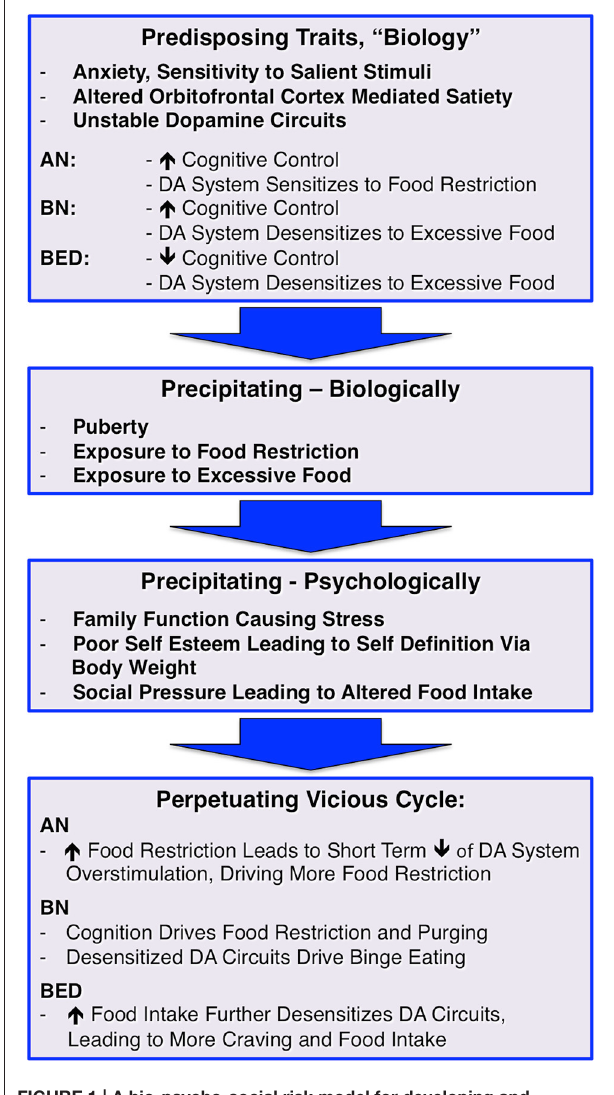
FIGURE 1 | A bio-psycho-social risk model for developing and maintaining eating disorders; dopamine, DA.